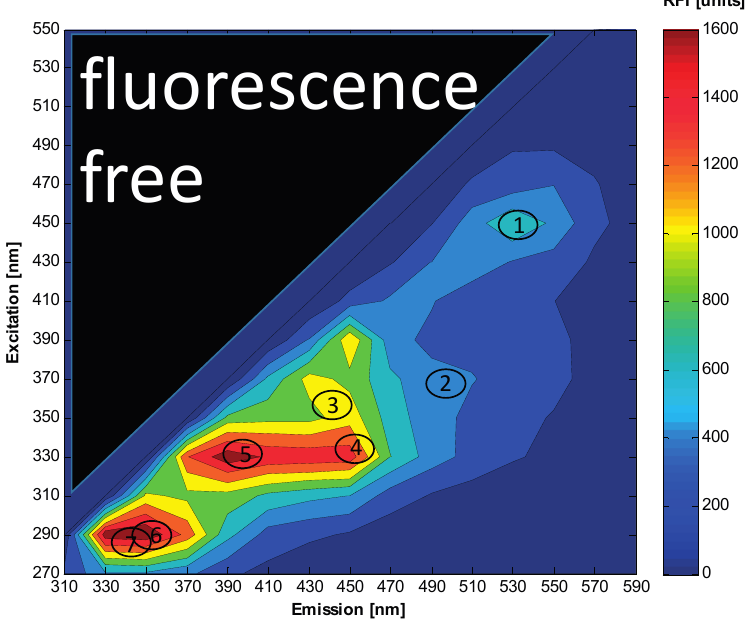
Figure 2. Contour plot of an excitation-emission matrix measured with the BioView ® sensor from S. cerevisiae cultivation with fluorescence maxima of flavin (1); riboflavin (2); NADH (3); NADPH (4); pyrodoxin (5); tryptophan (6) and tyrosine